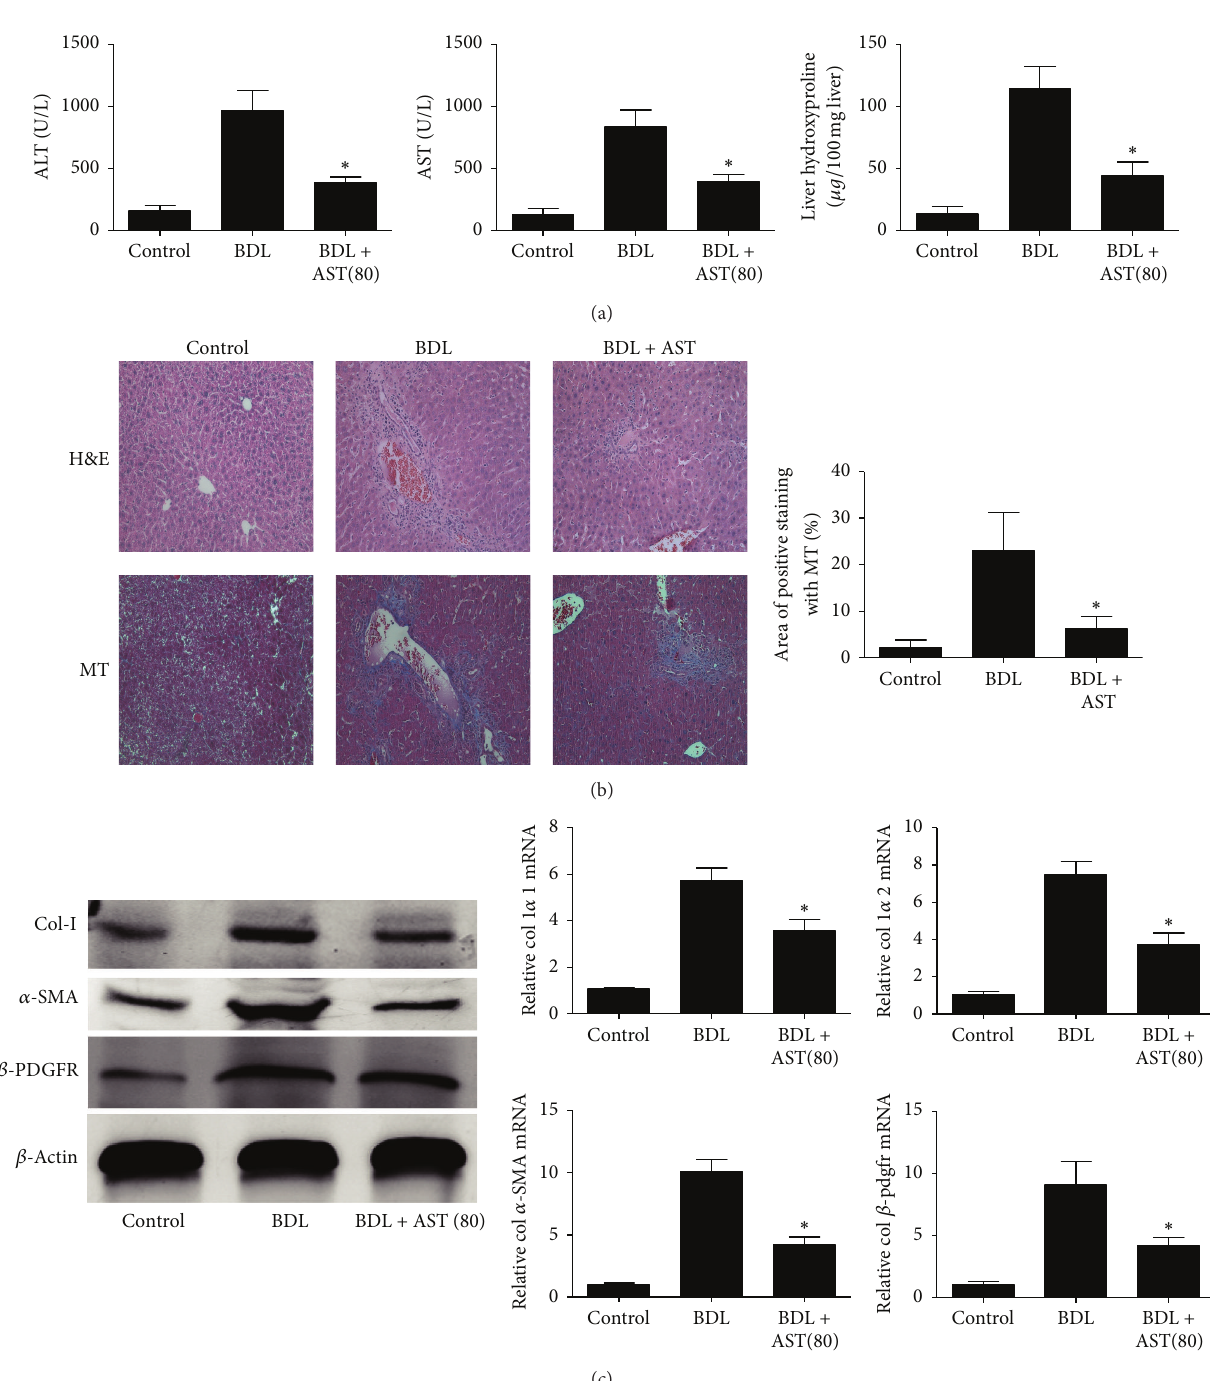
Figure 2: Effect of astaxanthin on BDL-induced liver fibrosis. (a) Astaxanthin decreased the level of ALT, AST, and hydroxyproline with the dose of 80 mg/kg. Data are expressed as mean ± SD ( 𝑛 = 10 , ∗ 𝑃 < 0.05 for BDL + AST(80) versus BDL). (b) Astaxanthin (80mg/kg) ameliorated pathological change showed by H&E and Masson’s trichrome (MT) (original magnification: ×200 ). The areas of positive staining with MT were analyzed by Image-pro Plus 6.0. There existed a significant decrease with astaxanthin (80mg/kg) treatment ( 𝑛 = 10 , ∗ 𝑃 < 0.05 for BDL + AST(80) versus BDL). (c) The analysis of western blotting and real-time PCR showed that astaxanthin obviously decreased the expression of 𝛼 -SMA, 𝛽 -pdfgr, and collagen I with the doses of 80mg/kg in BDL model ( 𝑛 = 3 , ∗ 𝑃 < 0.05 for BDL + AST(80) versus